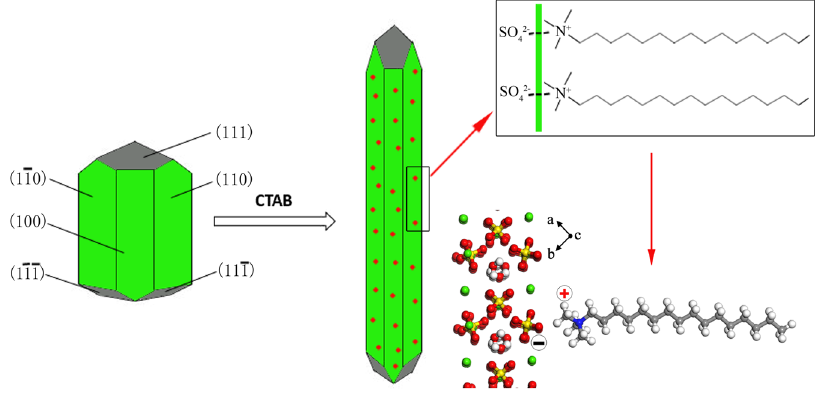
Figure 11. Schematic diagram of adsorption of CTAB on the surfaces of α -HH